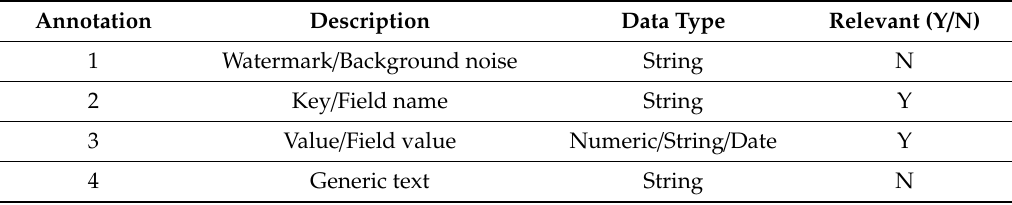
Figure 3. An example tax clearance certificate image (masked) illustrating the format of the images. Annotations on the image are explained in Table 1. Table 1. Annotation explanations as illustrated in Figure 3.